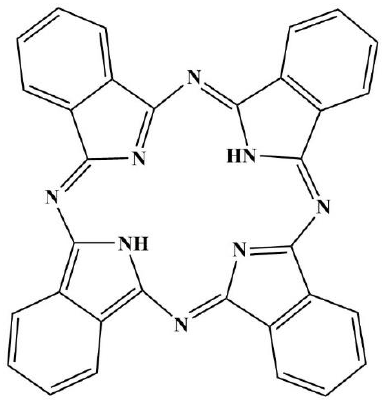
Figure 1. The molecular structure of phthalocyanine.